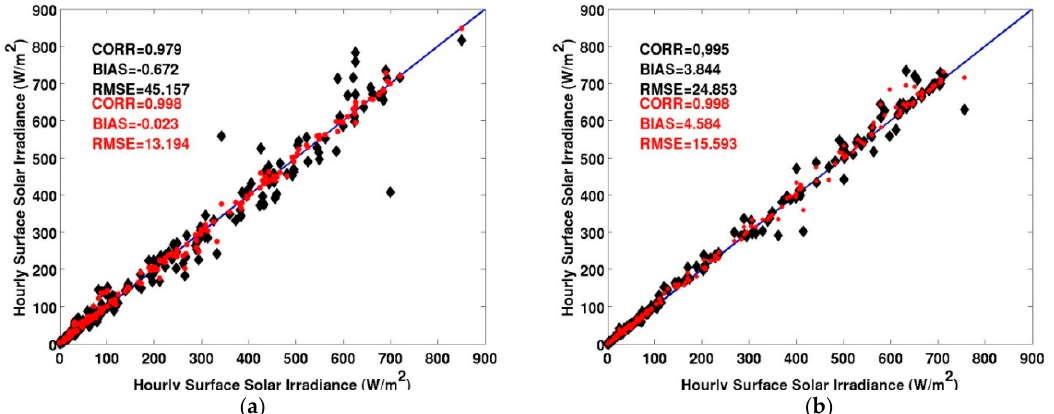
Figure 8. Hourly Surface Solar Irradiance scatter plots considering all data, based on 12-hourly (red circles) and 4-hourly (black diamonds) samplings. ( a ) IMAA/CNR; ( b )